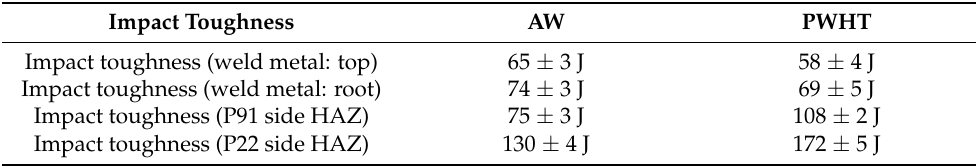
Table 4. Impact toughness of the dissimilar welded joint of P91 and P22 steel in AW and PWHT